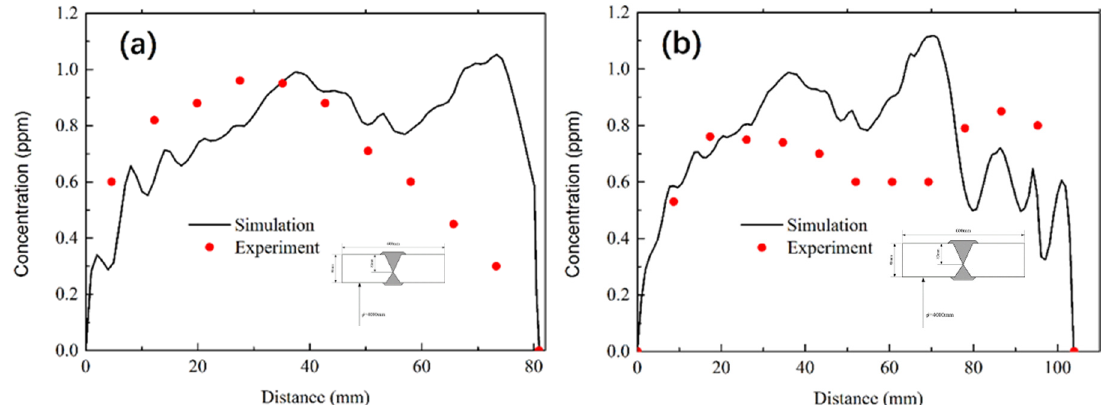
Figure 14. Comparison between simulation and test results of hydrogen concentration in thickness direction of heavy plate: ( a ) End of front welding; ( b ) End of back welding.